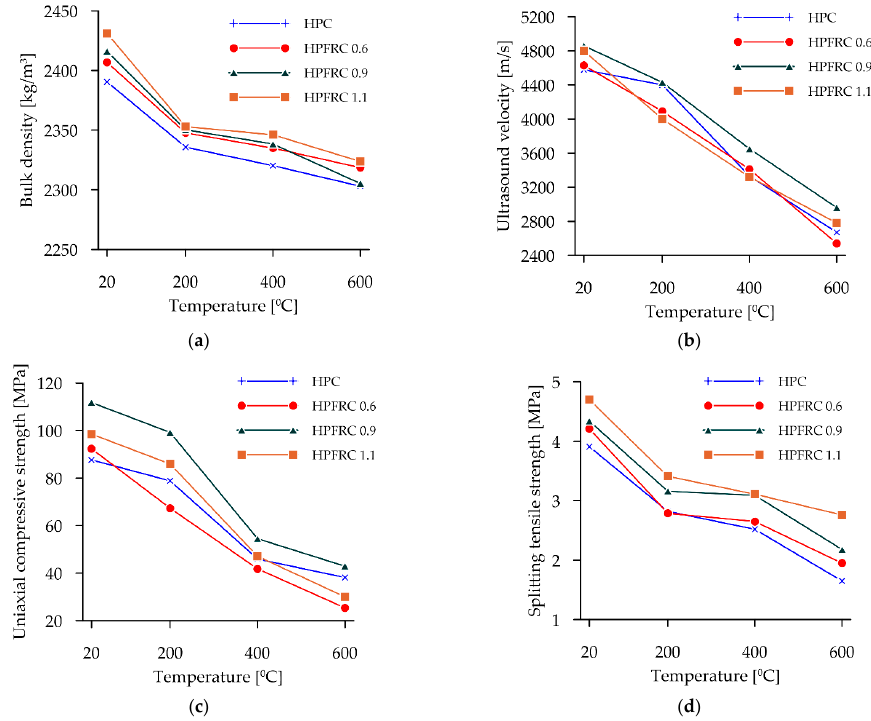
Figure 7. Basic test results: ( a ) bulk density; ( b ) ultrasound wave velocity; ( c ) uniaxal compressive strength; ( d ) tensile strength.